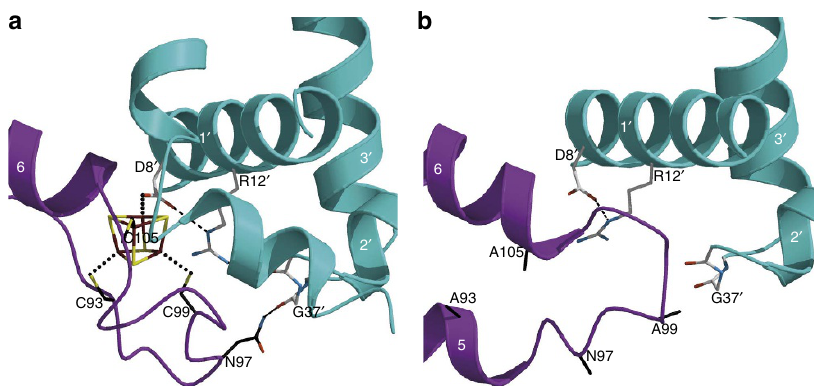
Figure 3 | Structural changes induced by the loss of the FeS cluster. ( a ) In holo ScNsrR Arg12 connects the Asp8 [4Fe–4S] cluster ligand with Val36 located next to the DNA-recognition helix ( a 3 0 RH). In addition, Asn97 from the other monomer establishes an H-bond with the carbonyl oxygen from Gly37. ( b ) The absence of the cluster in apo 3CA-ScNsrR causes the disruption of the Arg12-Val36 and Asn97-Gly37 H-bonds, which results in a shift of about 2.0Å of each of the ScNsrR homodimer